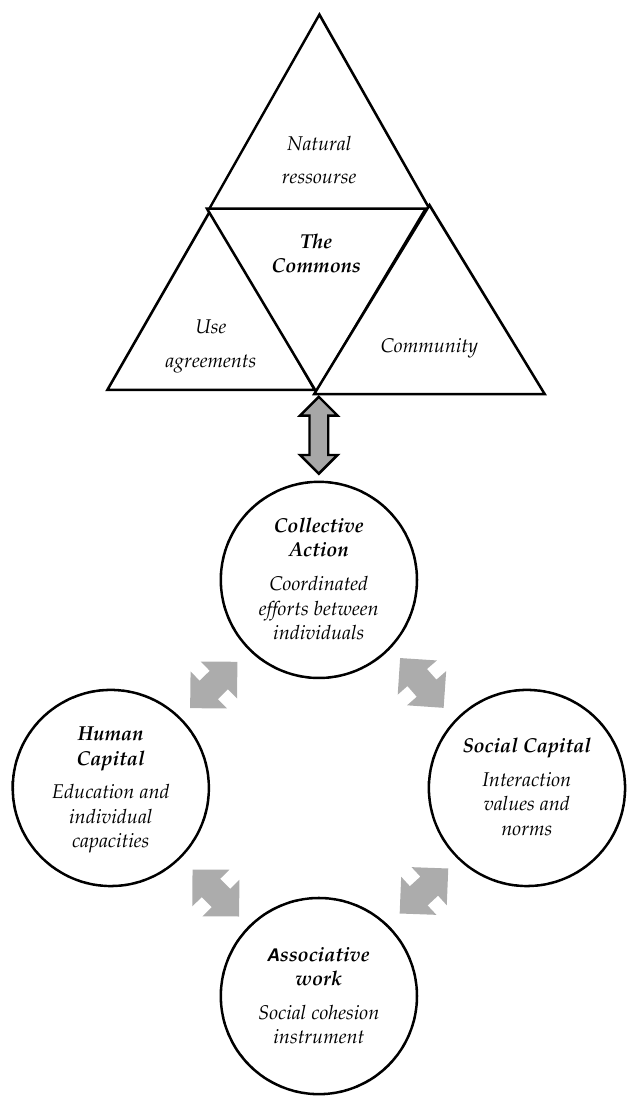
Figure 1. A framework for the analysis of collective action.